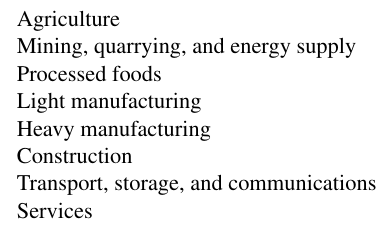
Table A1. List of sectors considered in the MRIA, ARIO, and IEES